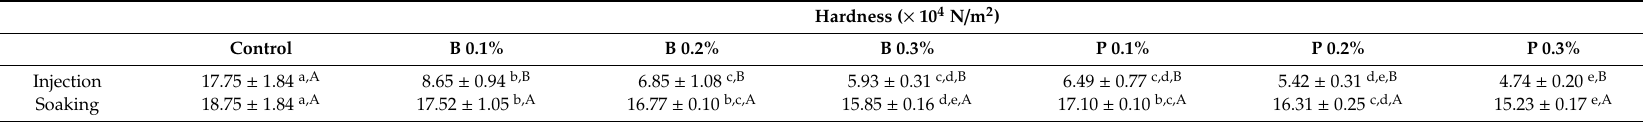
Table 3. Hardness of neritic squid muscle either injected with or soaked in bromelain (B) and papain (P) enzymes, versus untreated